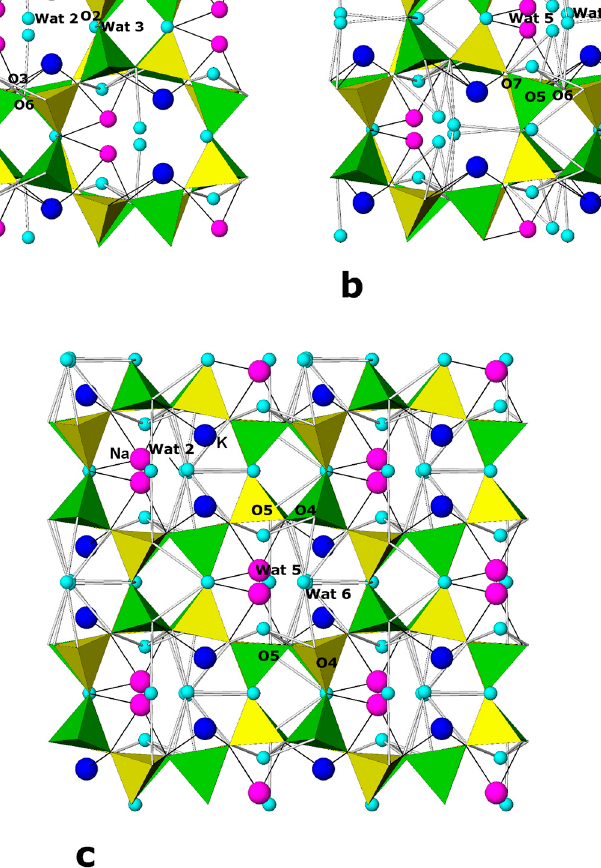
Figure 1. Projection of the amicite structure along the [001] direction at ( a ) P amb , ( b ) 1.25 GPa, and ( c ) 4.71 GPa. The projection of the structure at P amb (rev) is not reported, this being virtually identical to that at P amb . Purple spheres = Na; blue spheres = K; light blue spheres = water; yellow tetrahedra = Si; green tetrahedra = Al.